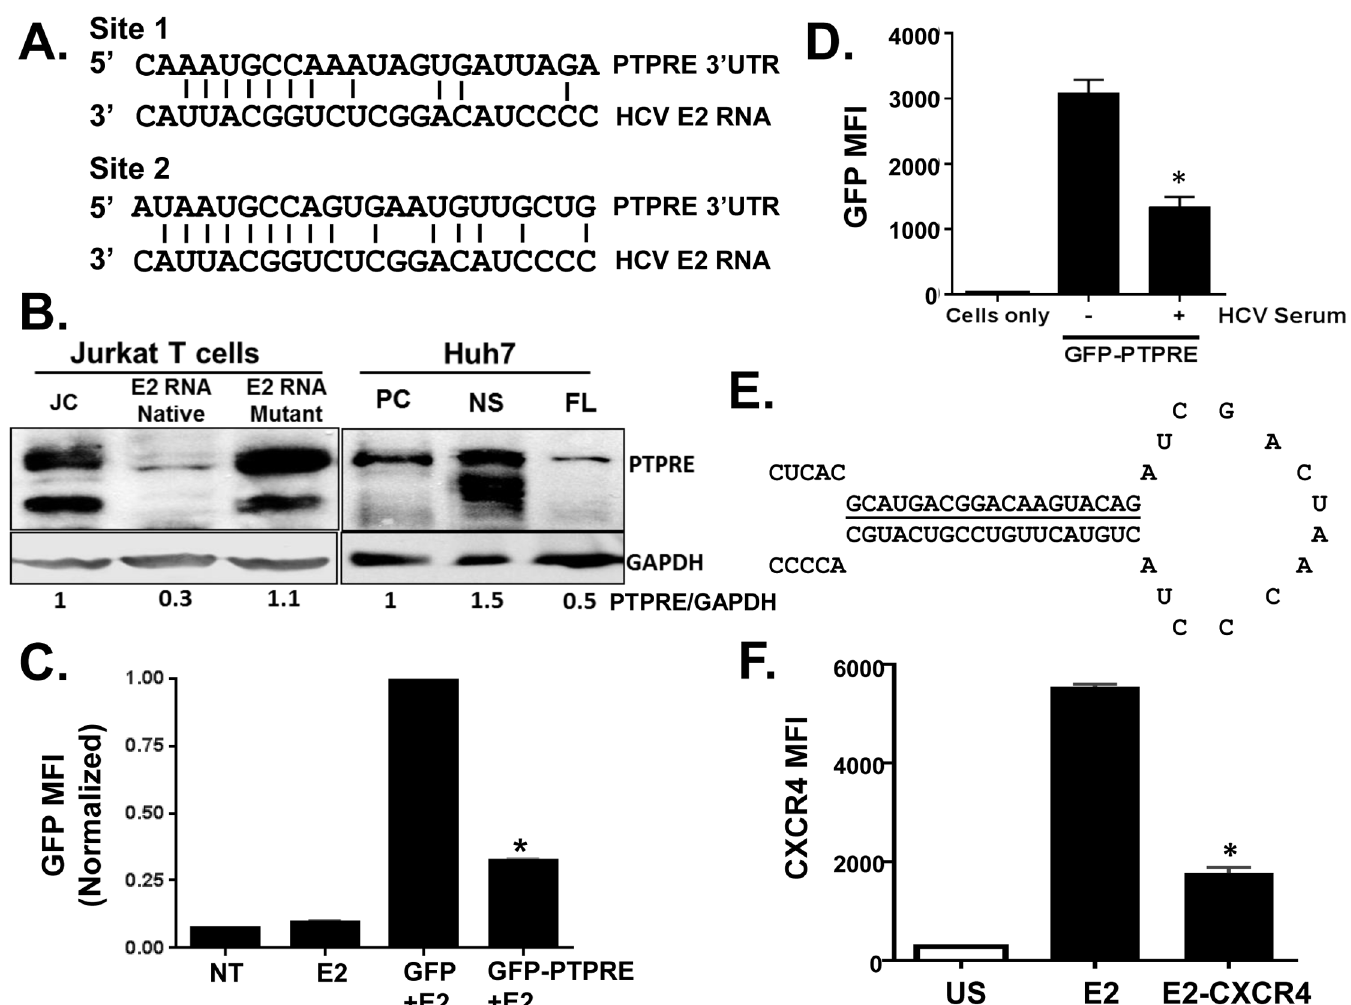
Fig 6. HCV E2 RNA inhibits protein tyrosine phosphatase receptor type E (PTPRE) expression. Sequence alignment of two sites within PTPRE 3 ’ untranslated region (UTR) predicted to bind to HCV E2 RNA (aa 603 – 619) region (A). Immunoblot analysis of PTPRE protein levels in control, HCV E2 RNA or HCV E2 mutant RNA expressing Jurkat cells, or Huh7 cells expressing full length HCV replicon (FL) or non-structural protein (NS) expressing replicon. The upper band represents full-length PTPRE with transmembrane domain (isoform-1) and lower band represents cytoplasmic PTPRE (isoform-2). GAPDH serves as a loading control (B). GFP expression by HEK 293 cells co-transfected with 1 μ g of plasmid DNA encoding GFP alone or GFP with PTPRE 3 ’ UTR sequence shown in panel A and 5 μ g of plasmid DNA encoding HCV E2 (C) or incubated with HCV-positive serum (D) and GFP expression measured after 72 hours. Data represent the average of three technical replicates and each experiment was repeated at least three times with consistent results. The region of HCV E2 targeting PTPRE was replaced with sequences targeting the cellular chemokine receptor CXCR4 (E), and a Jurkat cell line stably expressing this sequence was generated. CXCR4 was reduced in Jurkat cells expressing this HCV E2 sequence targeting CXCR4, but not Jurkat cells expressing the native HCV E2 RNA sequence (F). * P <